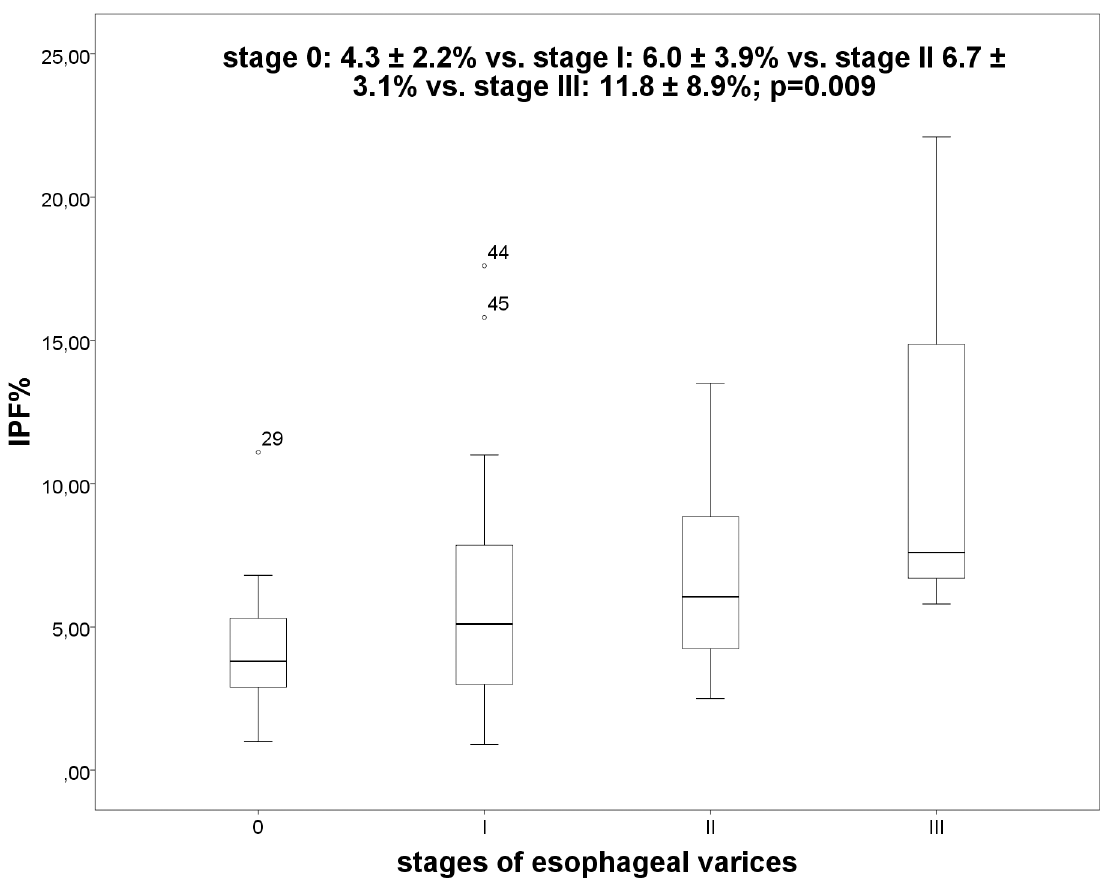
Fig 5. Boxplot: IPF% and stage of esophageal